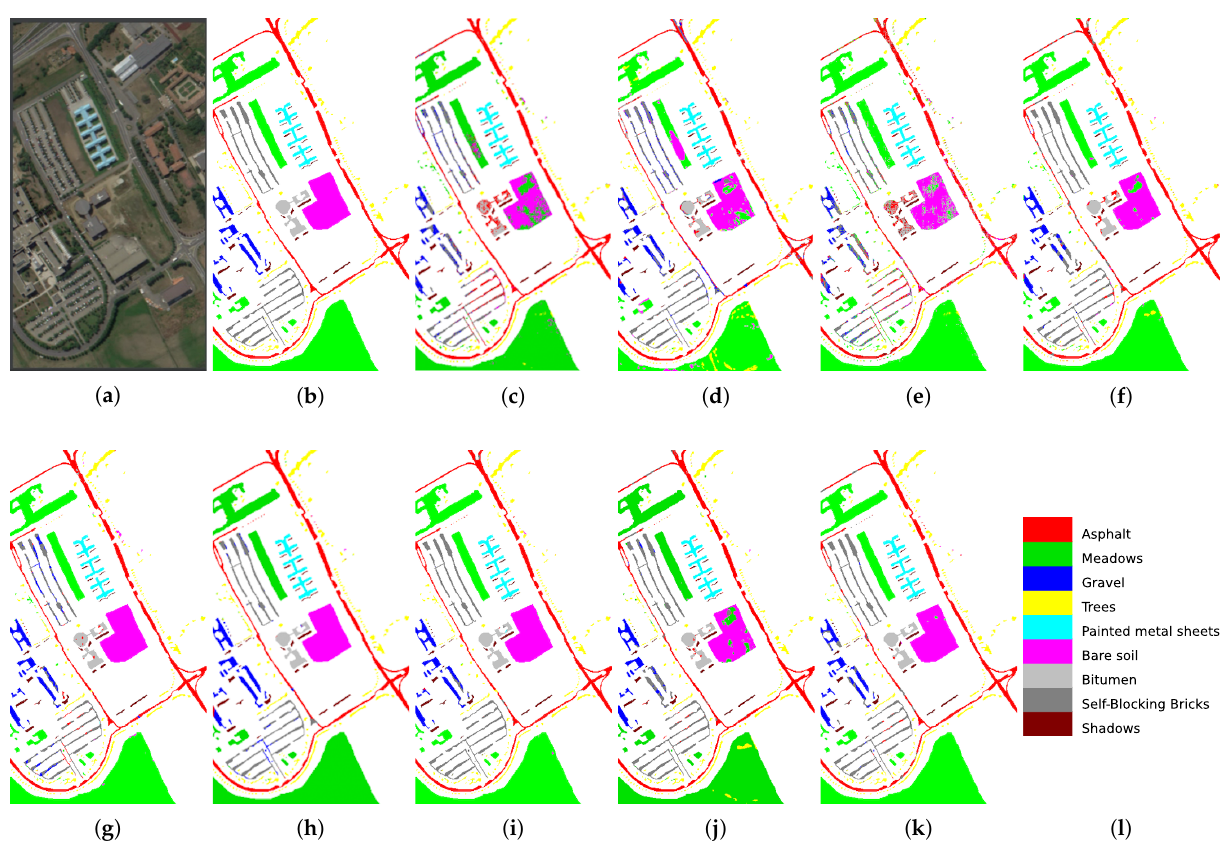
Figure 8. Classification maps of different methods on the UP dataset. ( a ) False-color; ( b ) Ground truth map; ( c ) 2D-CNN; ( d ) 3D-CNN; ( e ) Res-Net; ( f ) SSRN; ( g ) A2S2K; ( h ) MAFN; ( i ) DBDA; ( j ) A-SPN; ( k ) AETF-Net; ( l ) Color